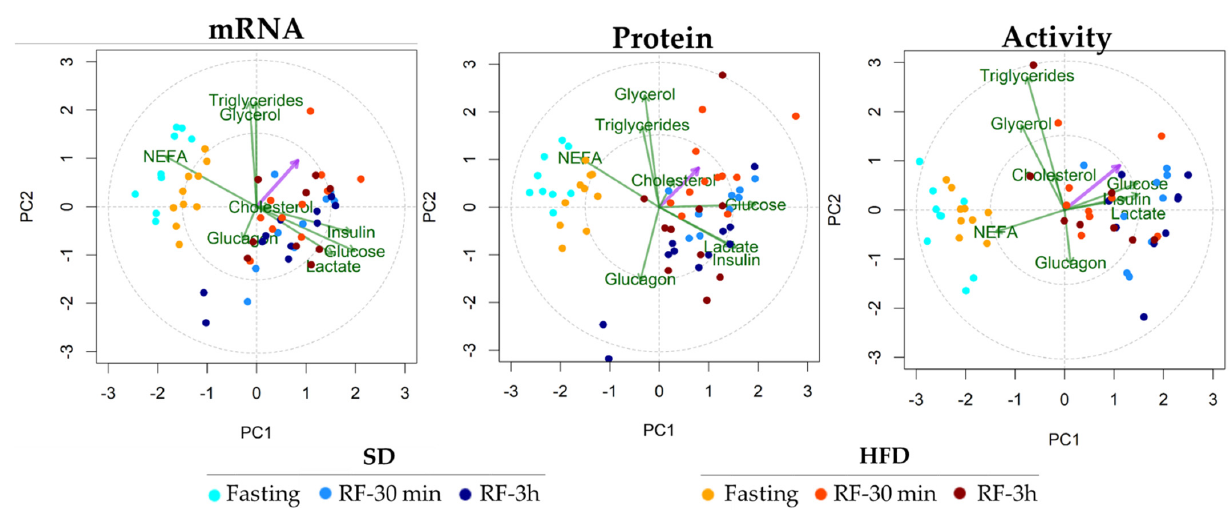
Figure 6. The biplots representation of physiological responses and hepatic IDE regulation in response to nutritional adaptations. The pink arrow shows the variable response (IDE mRNA, protein, or activity levels). The green arrow shows physiological variables (body weight, metabolites, or hormones). Agreement in the direction of pink arrow and green arrows can be interpreted as a graphical proxy for the strength of association between response variable and physiological variables (hormones and metabolites). Dots indicate different nutritional conditions depicted by color codes (see legend in Figure). PC1: principal component 1; PC2: principal component 1.